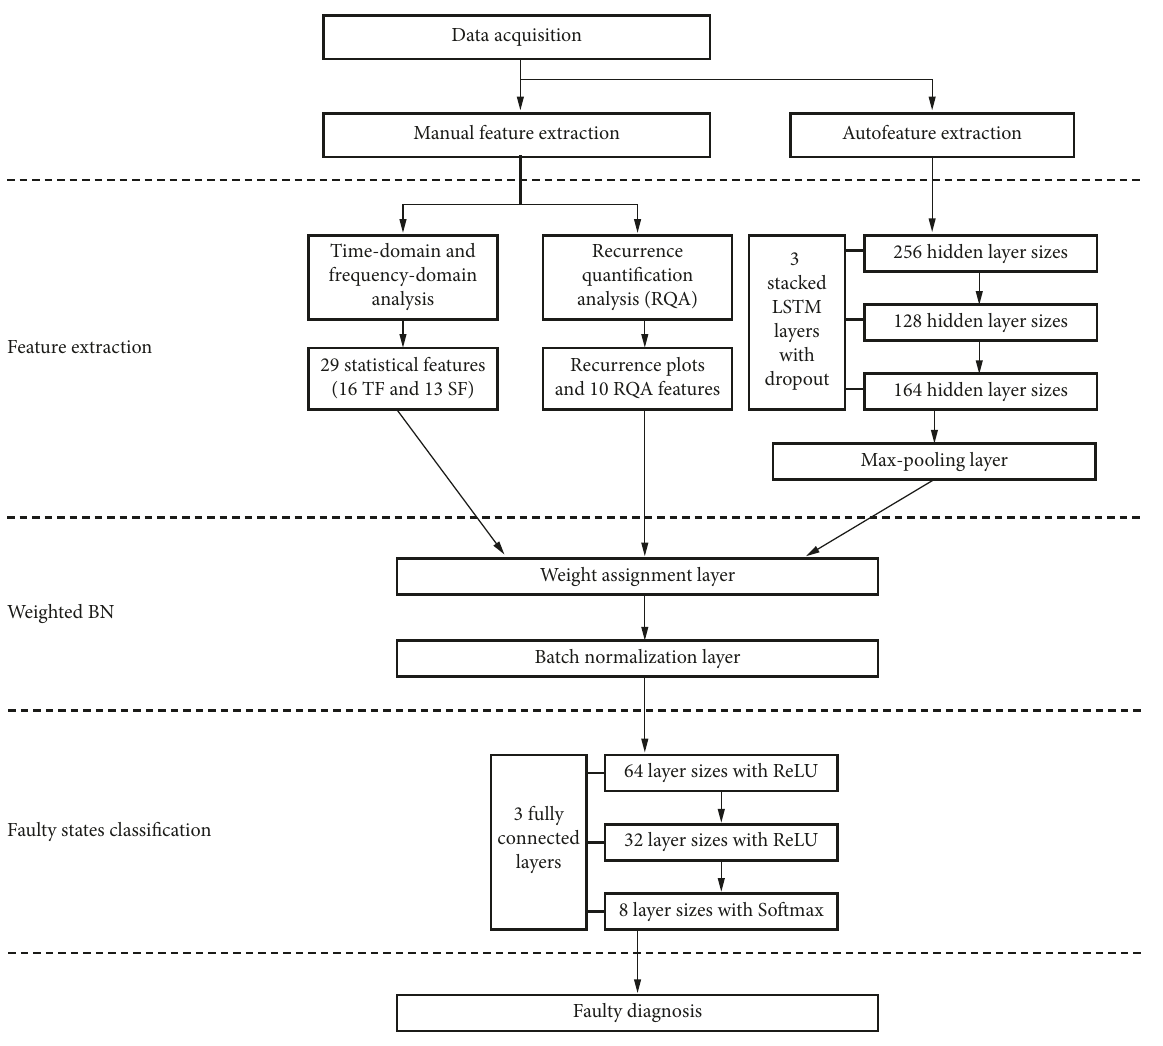
Figure 3: The flow diagram of the proposed method.